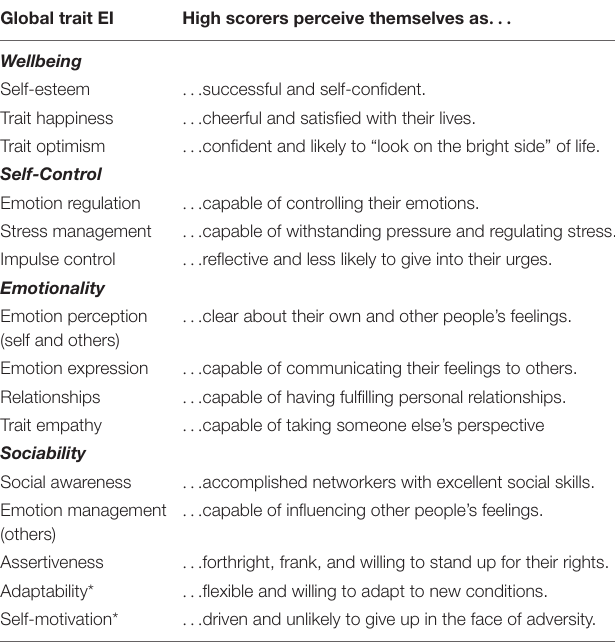
TABLE 1 | The sampling domain of trait emotional intelligence (EI) in adults. Global trait EI High scorers perceive themselves as ...